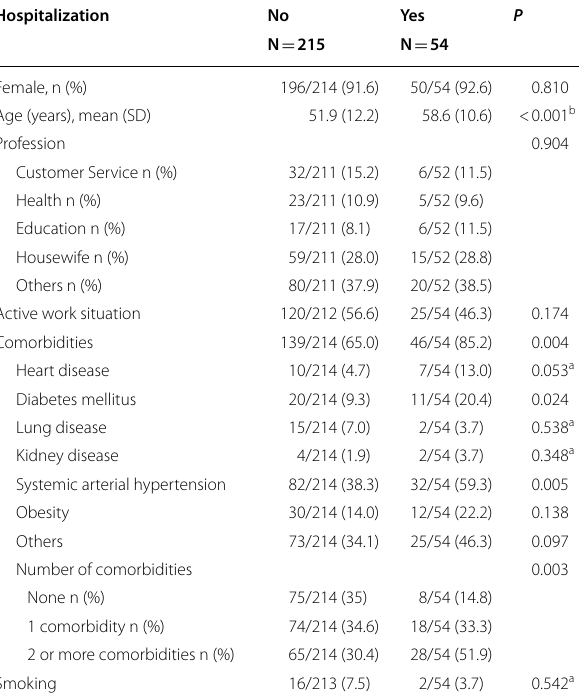
Table 1 General characteristics and comorbidities of patients with rheumatoid arthritis and COVID‑19